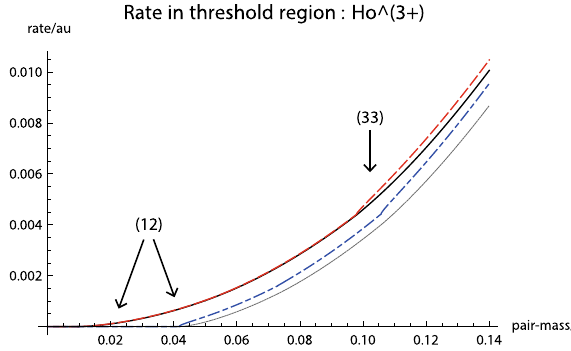
(cid:14) M 2 (θ ; r ) with r = − 0 . 36532 of Fig. 5 Rate vs neutrino-pair mass trivalent Ho. Cases of NO Majorana of smallest neutrino mass 1 meV in solid black, NO Majorana of 50 meV in dotted black, NO Dirac 1 meV in dashed red, and NO Dirac 50 meV in dash-dotted blue. Two arrows indicate the largest threshold rises of (12) and (33) pair-production